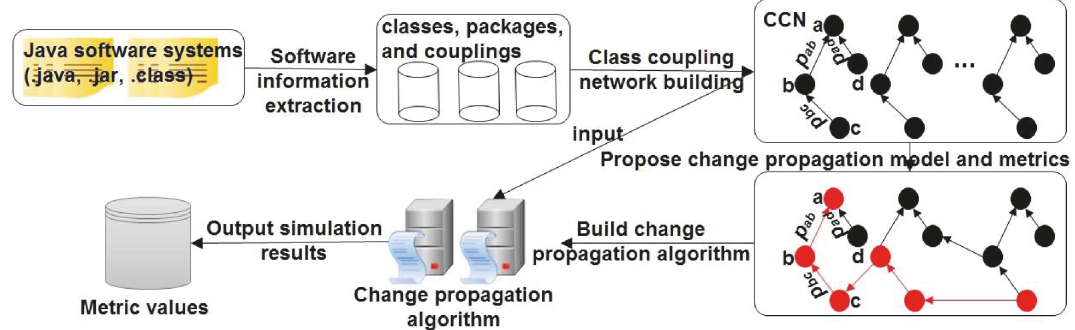
Figure 1: The overall framework of our